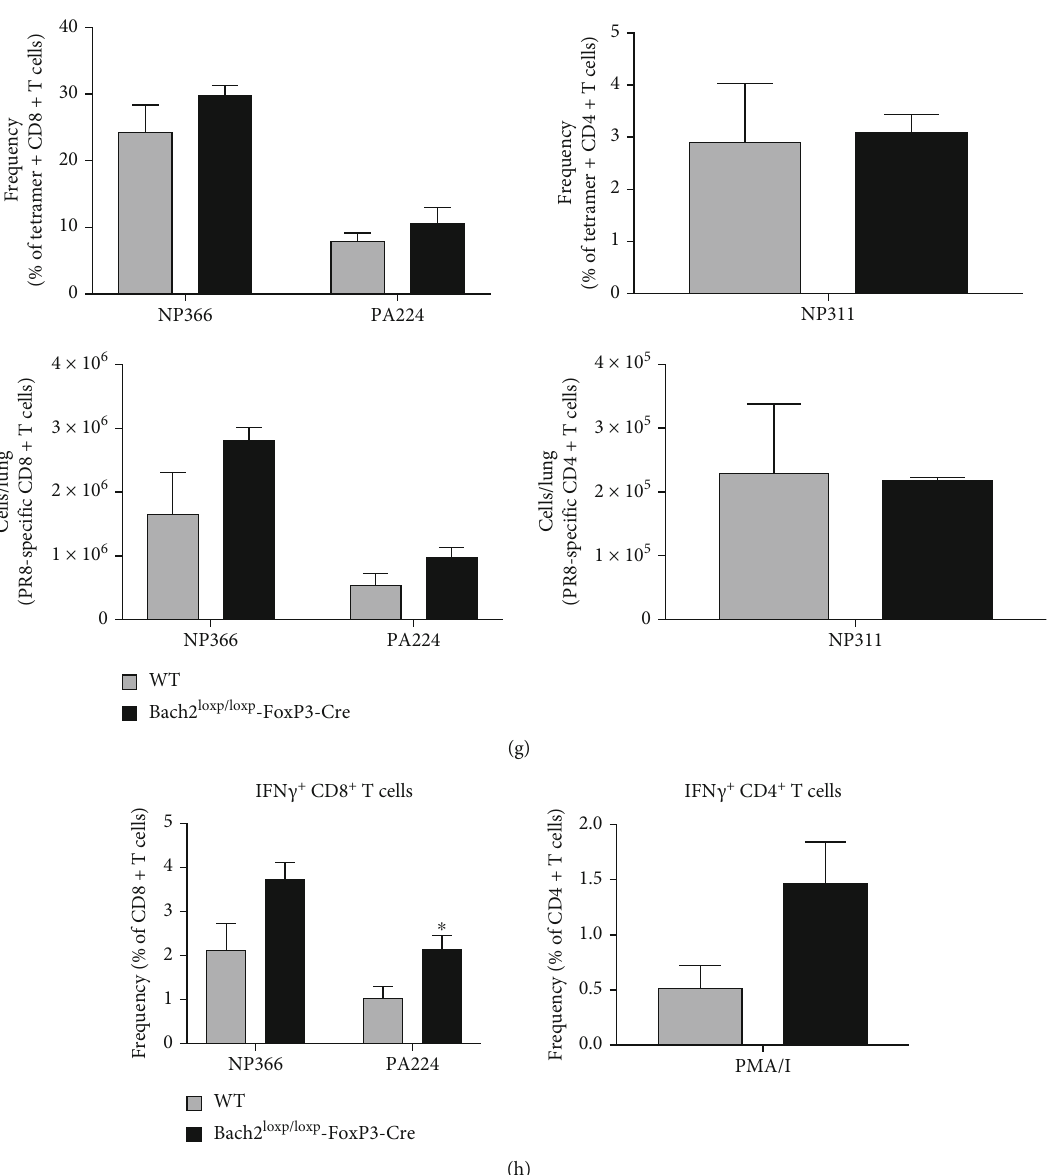
Figure 4: Bach2-de fi ciency in Tregs does not a ff ect systemic or mucosal Type 1 immunity. WT and Bach2 loxp/loxp FoxP3-Cre mice were infected with (a-d) LCMV-Armstrong or (e-h) PR8/H1N1 in fl uenza virus, and Tregs were analyzed by fl ow cytometry. (a) Frequency and numbers of splenic Tregs in LCMV-infected mice. (b) Frequency of e ff ector Treg subsets in the spleen. (c) Frequency and numbers of tetramer binding CD8 (speci fi c to NP396 or GP33 epitopes) and CD4 (speci fi c for GP66 epitope) T cells in the spleen. (d) Splenocytes were stimulated for 5hrs in vitro with LCMV peptides in the presence of Brefeldin A, and cytokine production was measure by intracellular staining for IFN γ in CD8 and CD4 T cells from the spleen. (e) Frequency and numbers of Tregs in the lung of in fl uenza virus-infected mice. (f) Frequency of e ff ector Treg subsets in the lung. (g) Frequency and numbers of in fl uenza virus-speci fi c CD8 (speci fi c to NP66 and PA224 epitopes) and CD4 (speci fi c to NP311 epitope) T cells in the lung. (h) Mononuclear cells from the lung were stimulated for 5hrs in vitro with PR8 peptides or PMA and ionomycin in the presence of Brefeldin A, and cytokine production was measured by intracellular staining of IFN γ in CD8 and CD4 T cells from the lung. This experiment was repeated three times with similar results, 4-5 mice per group. ∗ p < 0 : 05